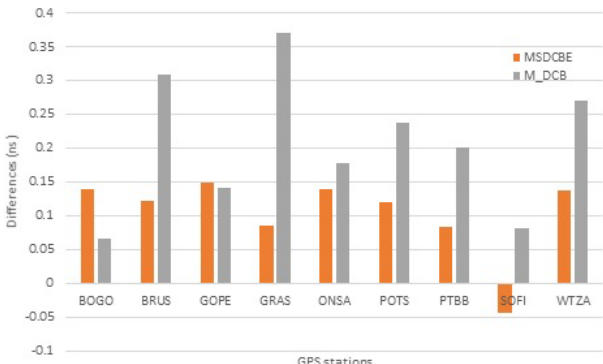
Figure 3. Mean difference between the receiver DCB values of CODE and the computed values by each of MSDCBE and M_DCB estimated from 1 to 31 January